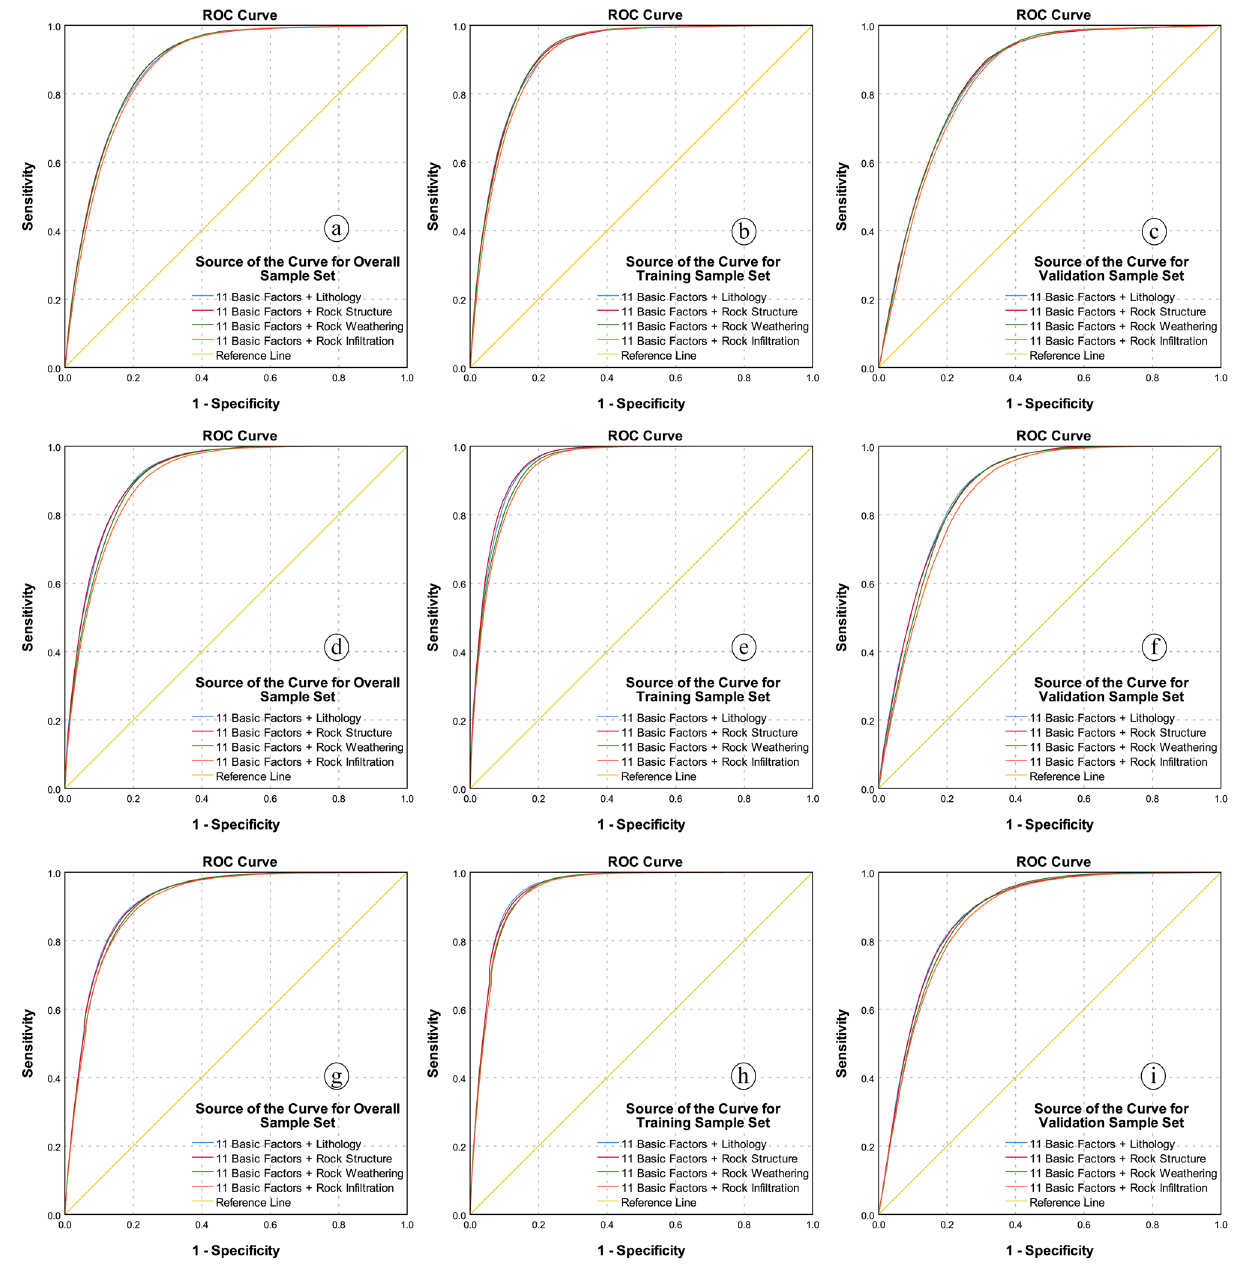
Figure 14. ROC curves analysis for ( a ) overall sample set by LR model, ( b ) training sample set by LR model, ( c ) validation sample set by LR model, ( d ) overall sample set by ANN model, ( e ) training sample set by ANN model, ( f ) validation sample set by ANN model, ( g ) overall sample set by SVM model, ( h ) training sample set by SVM model, and ( i ) validation sample set by SVM